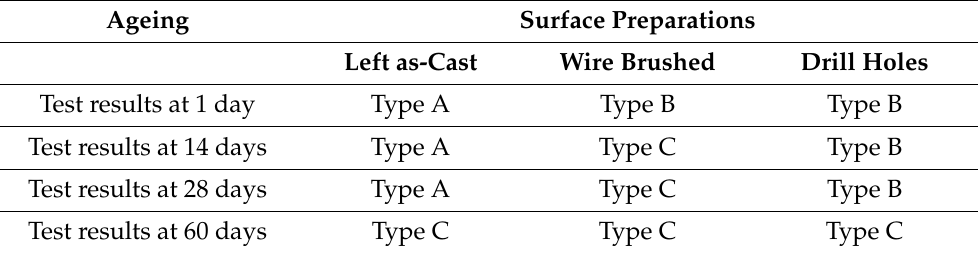
Table 3. The failure patterns of the GRM/OPCC composite after the slant shear